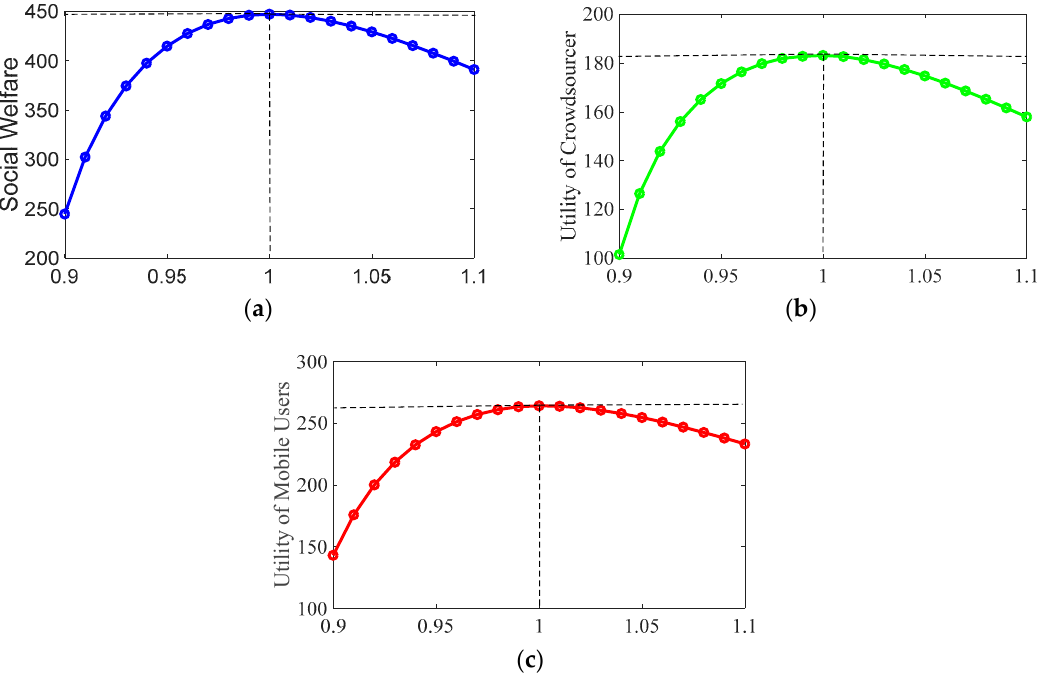
11 of 14 ( c ) Figure 3. Utility changes with the iteration process in our proposed algorithm: (a) utility of the crowdsourcer; (b) utility of mobile user 𝑢 (cid:2869) , 𝑢 (cid:2877) ,𝑢 (cid:2869)(cid:2874) , and 𝑢 (cid:2870)(cid:2868) ; and (c) social welfare. In Figure 4, the result of our proposed scheme is represented by the summit, while the curves correspond to the performance of crowdsourcer centric scheme. The basic principle of the latter scheme is explained as follows. The market is assumed to be dominated by the crowdsourcer, which can adjust the obtained stable prices as it wants. For simplicity, the adjusted prices were assumed to range from 90% to 110% of the convergent prices obtained in our proposed scheme. The crowdsourcer adjusts the prices in all subareas simultaneously. Under the adjusted prices, the crowdsourcer calculates the optimal demands in each subarea based on the maximization of its own utility. Then, under the constraint of the match between demand and supply, the supply of each mobile user is calculated based on the maximization of the total utility of all mobile users. As shown in Figure 4a, social welfare by the crowdsourcer-centric scheme changed with the adjusted prices. We can find that only when the adjusted prices equal the convergent prices in our